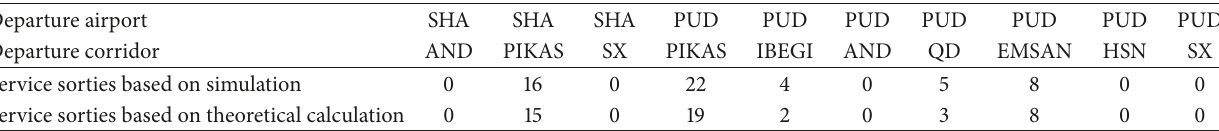
Table 10: Departure route capacity comparison between simulation data analysis and theoretical calculation for the fifth flight path in one hour.